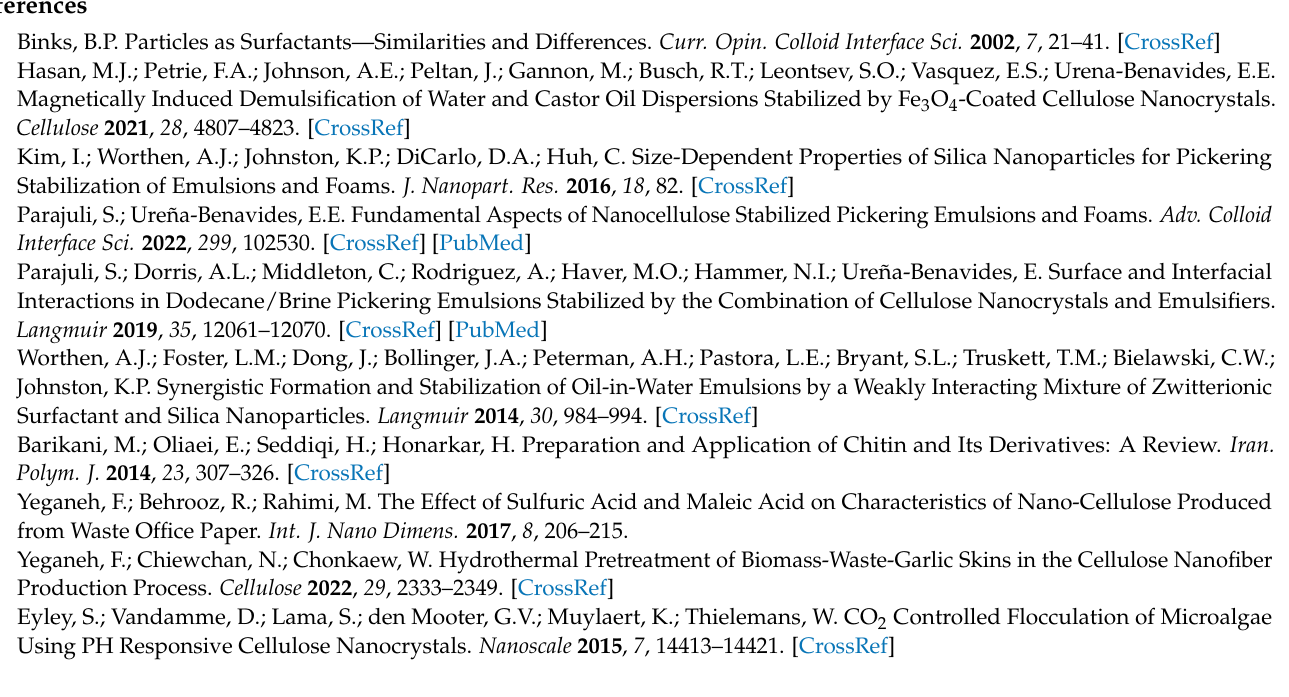
stability with varying NaCl concentration. Figure S2. Preliminary screening of emulsion stability with individual NP concentrations. Figure S3. Preliminary screening of emulsion stability with varying ChNC:CNC mass ratio. Figure S4. Long-term emulsion stability screening with varying total NP concentration. Figure S5. CNC (left) and ChNC (right) length distributions. Figure S6. Conductometric titration of (a) ChNC and (b) CNC. Figure S7. Complete Raman spectra of CNC, CNC, and ChNC-CNC mixtures from 200 to 3600 cm − 1 . Figure S8. (a) Raman spectra of ChNC, CNC, and ChNC/CNC mixtures from 200 to 1200 cm − 1 . (b) Raman spectra showing bands used for Raman mapping. Figure S9. Raman maps of a 1:1 ChNC/CNC thin film on